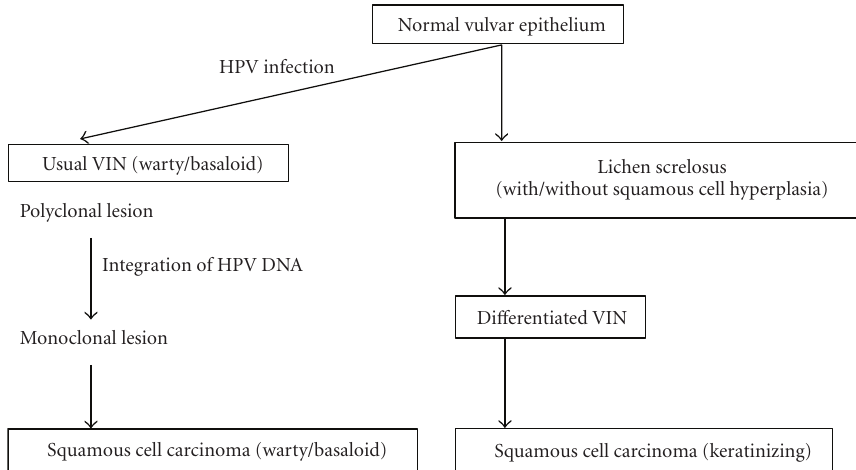
Figure 2: Pathogenesis of squamous cell carcinoma of the vulva. (Distinct pathways for carcinogenesis of keratinizing and warty/basaloid types of vulvar SCC from normal epithelium through precursor lesions are demonstrated.)